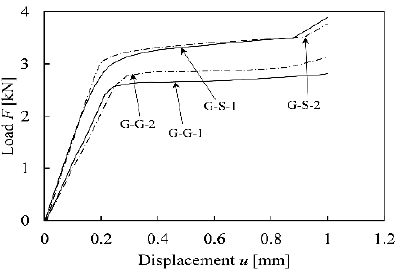
Figure 5. The load–displacement curves of specimens with different cover plates.